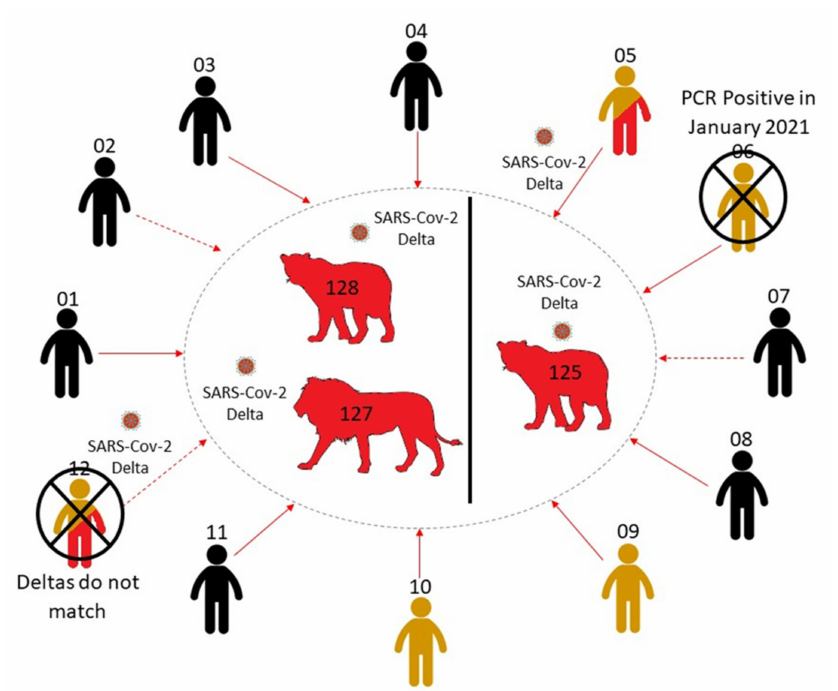
Figure 4. A summary of the potential infection route from animal handlers to the three lions. Direct (solid line) and indirect (dashed line) human contacts were traced and tested for SARS-CoV-2 RNA and IgG antibodies. Negative cases are coloured in black. PCR positive cases are coloured in red, while serologically positive cases are coloured in yellow. The two contact cases which were unlikely to be responsible for infecting the lions, owing to differing Delta sequences (ZRUCWL012) and previous positive tests (ZRUCWL006) are marked with a